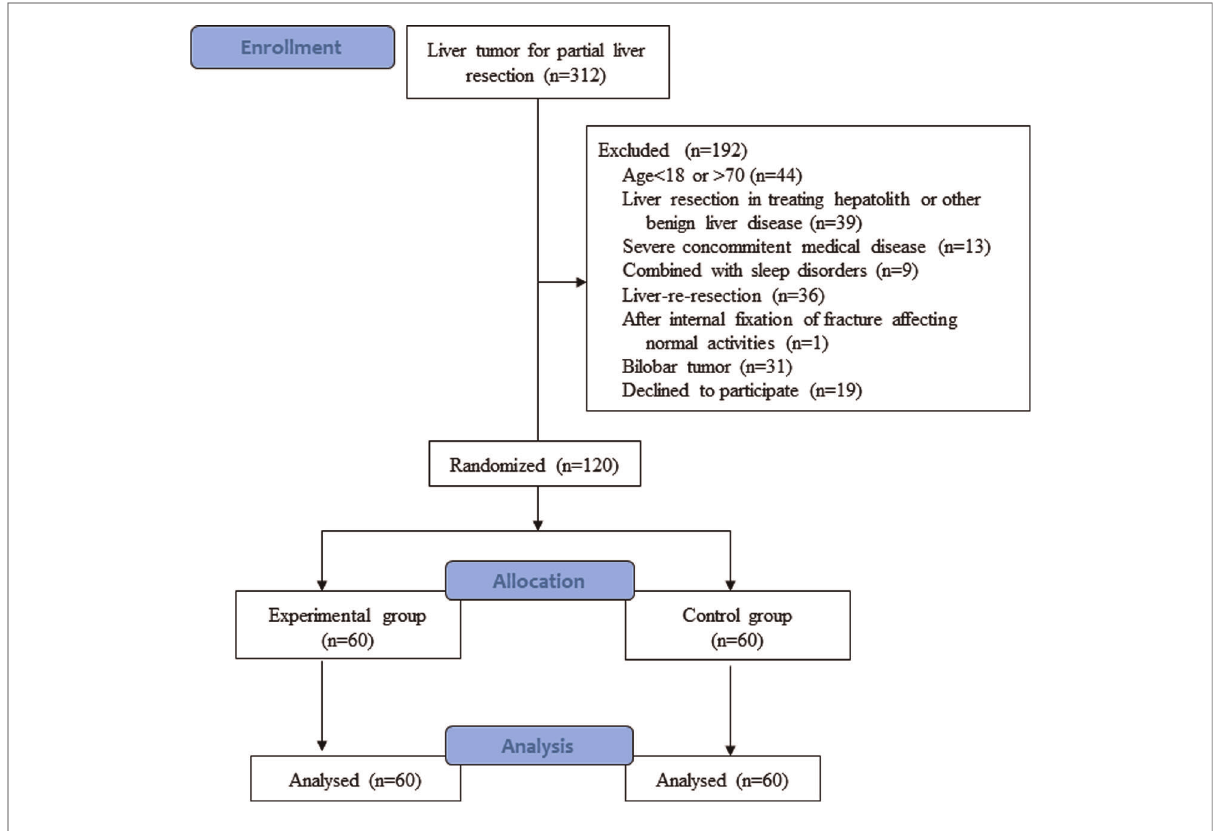
FIGURE 1 Flowchart of the patients enrolled in this